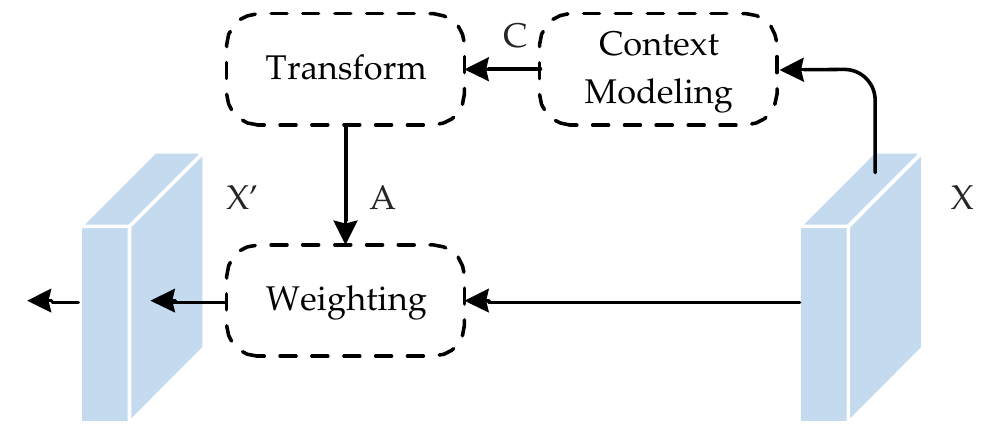
Figure 1. General contextual re fi nement framework.